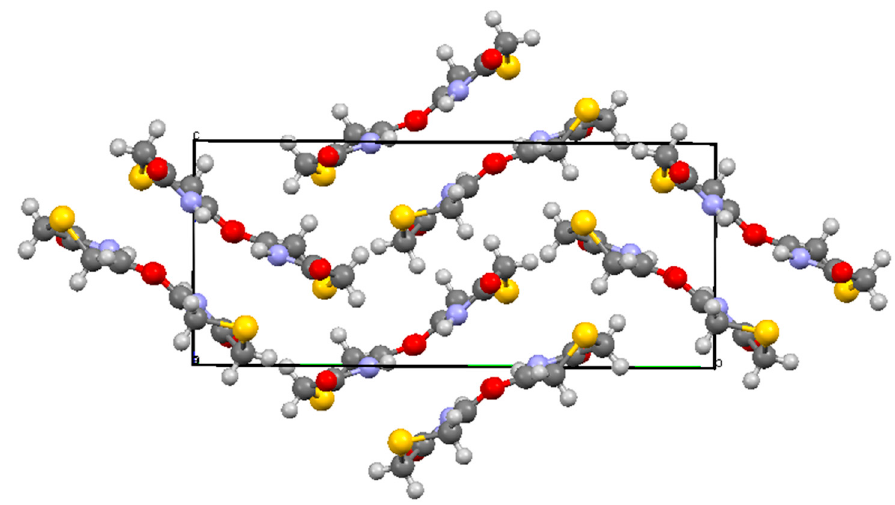
Figure 2. Unit cell of 1 viewed along the a axis showing the 8 molecules present along with their hydrogen bonded partners.